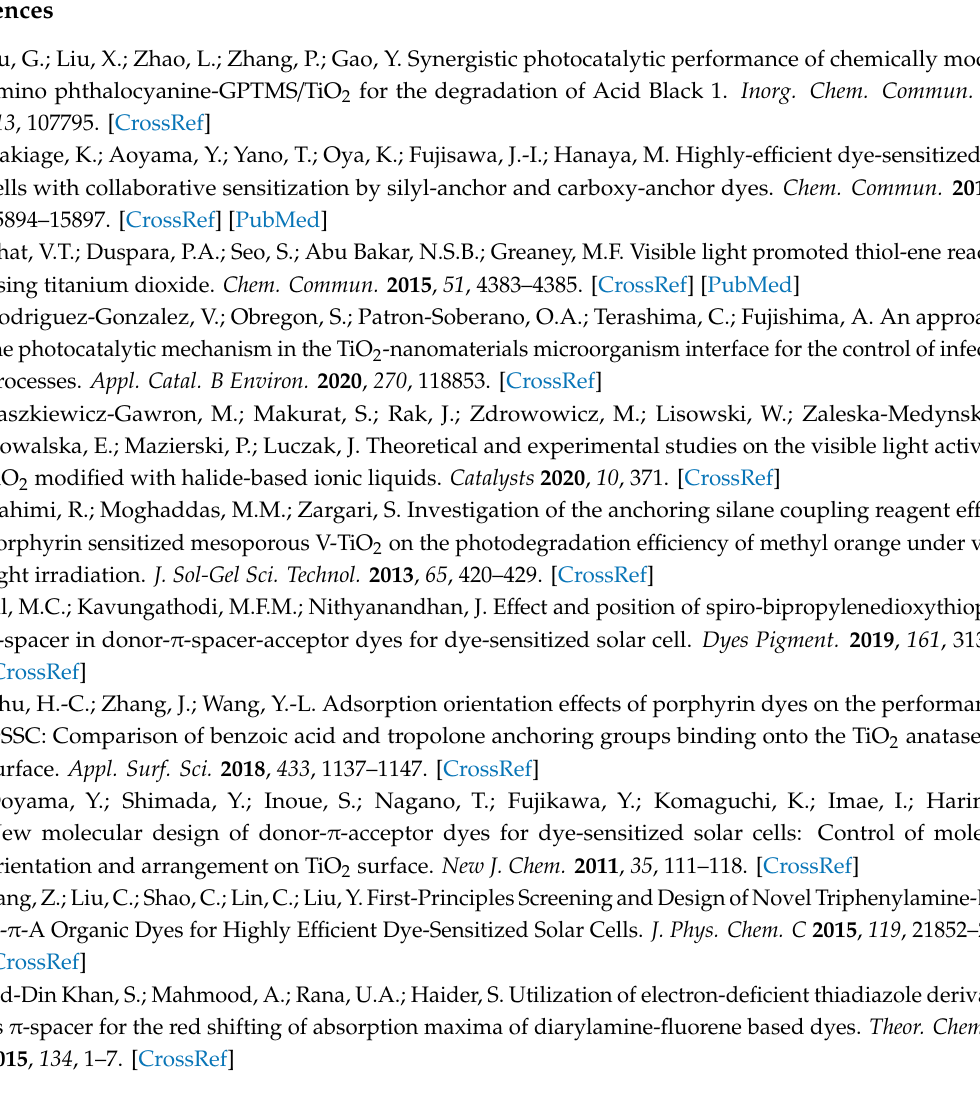
Figure S1: Chemical structures of 4-(triethoxysilyl)butane-1,2-epoxide (OTES–C2), 4-oxiran-2-ylbutyl-triethoxysilane (OTES–C4) and 8-oxiran-2-yloctyltriethoxysilane (OTES–C8); Figure S2: Optimized structures of CV 0 , CV iso and CV + in the gas phase. Geometry optimization was performed at the B3LYP / 6-31G* and SVWN / 6-31 + G** levels of theory. (See Sections 2 and 3 for further details); Figure S3: HOMO and LUMO of CV using CPCM in EtOH. In the cases of CV 0 and CV iso , the B3LYP / 6-31G* level of theory was employed for the FMO calculations. The HOMO and LUMO of CV + were calculated using the B3LYP / 6-31 + G** and SVWN / 6-31 + G** levels of theory. Surface isovalue: 0.02 e / bohr 3 ; Figure S4: Calculated energy levels of the HOMOs (blue lines) and the LUMOs (red lines) of CV 0 , CV iso and CV + using CPCM in EtOH; Figure S5: Optimized structures of CV 0 –OTES–C4, CV 0 –OTES–C8, CV iso –OTES–C4 and CV iso –OTES–C8 in the gas phase, calculated at the B3LYP / 6-31G* level of theory; Figure S6: Simulated UV-visible absorption spectra of (A) CV 0 –OTES–Cn and (B) CV iso –OTES–Cn in the gas phase, calculated using the TD-B3LYP / 6-31 + G* level of theory. Vertical lines indicate the calculated oscillator strength; Figure S7: HOMOs and LUMOs of CV–OTES–C4 and CV–OTES–C8 using CPCM in EtOH, calculated using the B3LYP / 6-31G* level of theory. Surface isovalue: 0.02 e / bohr 3 ; Figure S8: Calculated energy levels of the HOMOs (blue lines) and LUMOs (red lines) for CV–OTES–Cn using CPCM in EtOH; Figure S9: Optimized structure of a Ti 6 O 15 H 6 cluster modeling the anatase (101) surface, calculated using the B3LYP / 6-31G* / LanL2DZ level of theory. Gray, red and white atoms correspond to Ti, O and H, respectively, Figure S10: Molecular length of CV–OTES–C2 adsorbed on the TiO 2 cluster. Funding: This research received no external